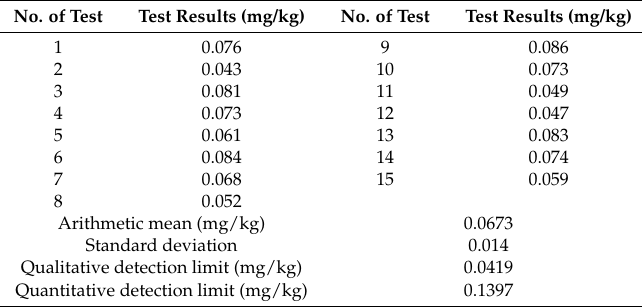
Table 3. Instrument detection limits ( n =